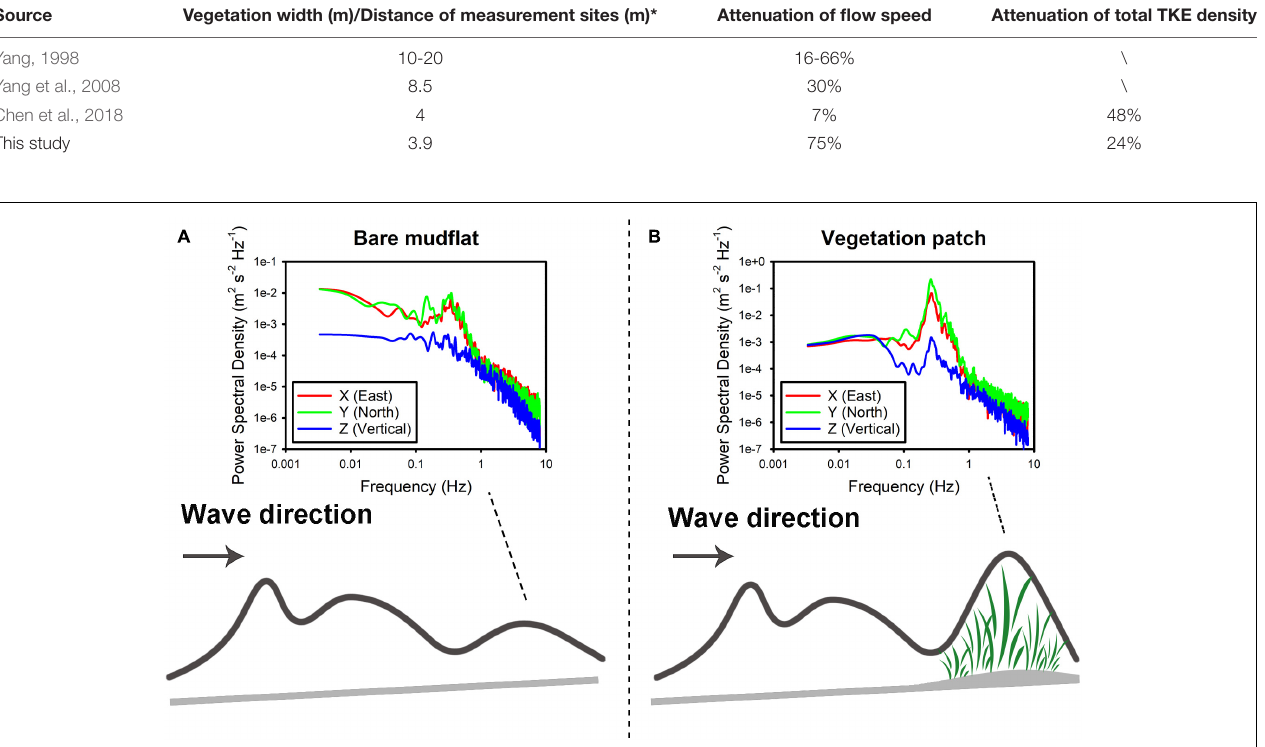
TABLE 3 | Attenuation comparisons of flow speed and total TKE density from bare mudflat to Scirpus saltmarsh.